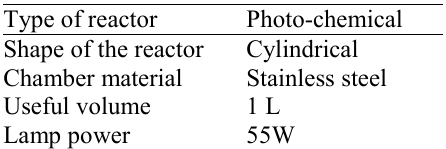
Fig. 2. Schematic view of reactor; 1) transformator; 2) low pressure Hg UV lamp; 3) quartz jacket; 4) stainless steel jacket; 5) photocell; 6) pump; 7) sample vessel; 8) shaker; 9) sampling tube Table 1. Features of reactor